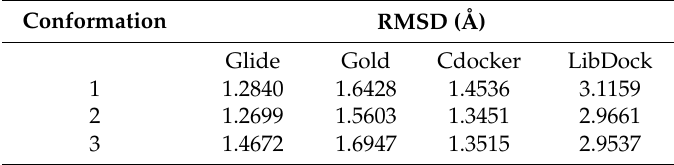
Table 1. RMSD of top 3 configurations obtained through docking for docking reliability